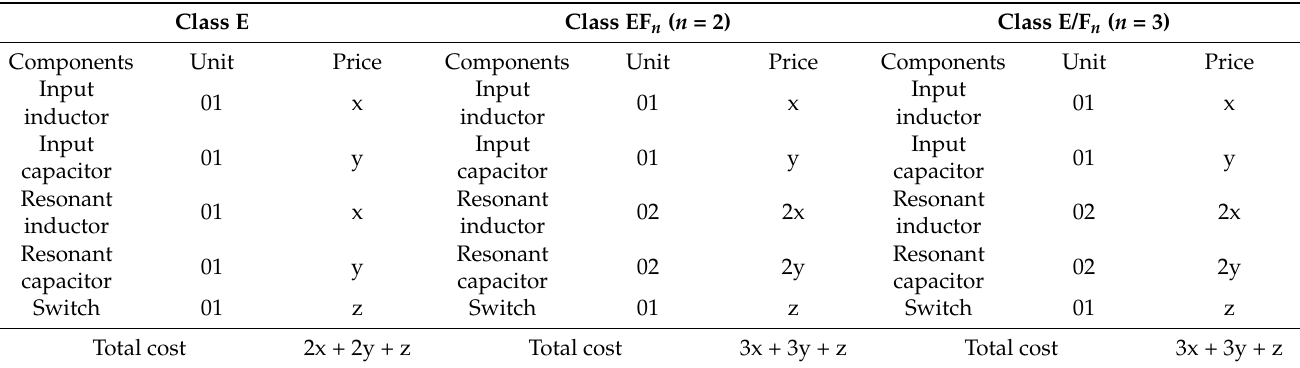
Table 5. Cost Comparison